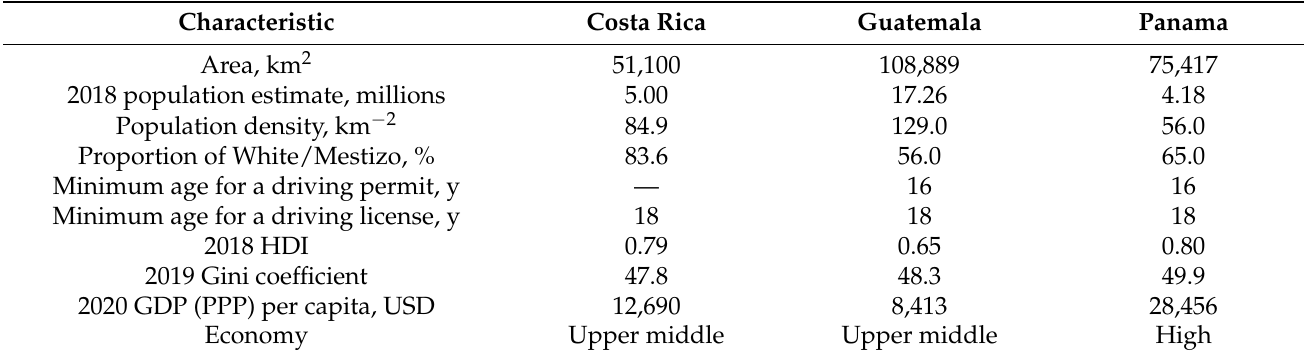
Table 1. Overview of the three countries included in the